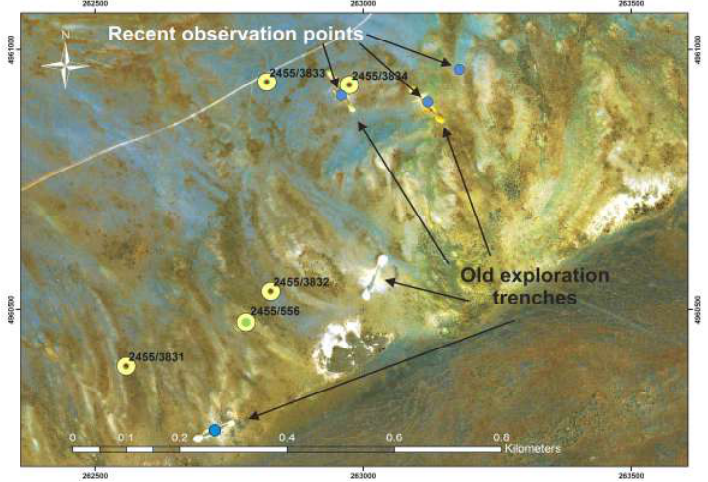
Figure 7. Old exploration trenches and recent observation points in Mandakh area. Raster basis: SASPlanet ESRI ArcGIS Imagery.